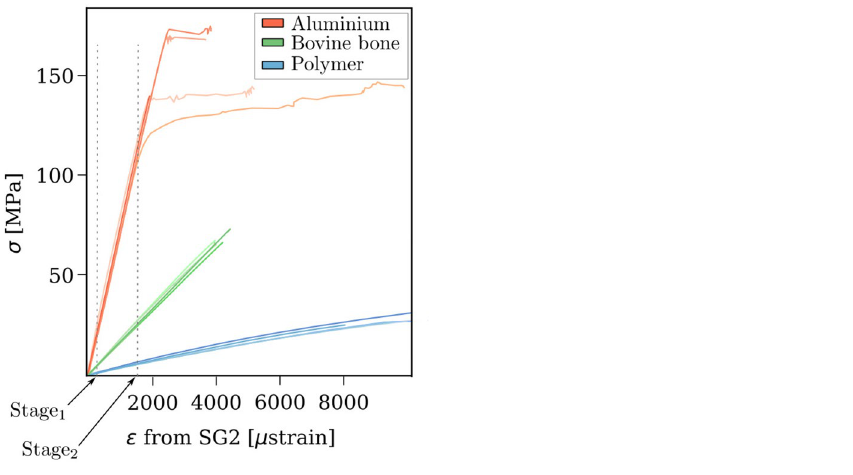
Figure 5. Stress–strain curve of all tested specimens. Aluminium in red, bovine bone in green and polymer in blue. The error evaluation was done at two deformation stages, approximately at 500 μstrain and 1750 μstrain. Five specimens were tested from each